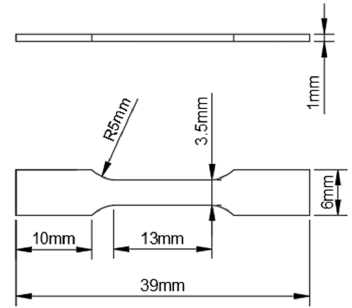
Figure 8. Dimension of tensile specimens.